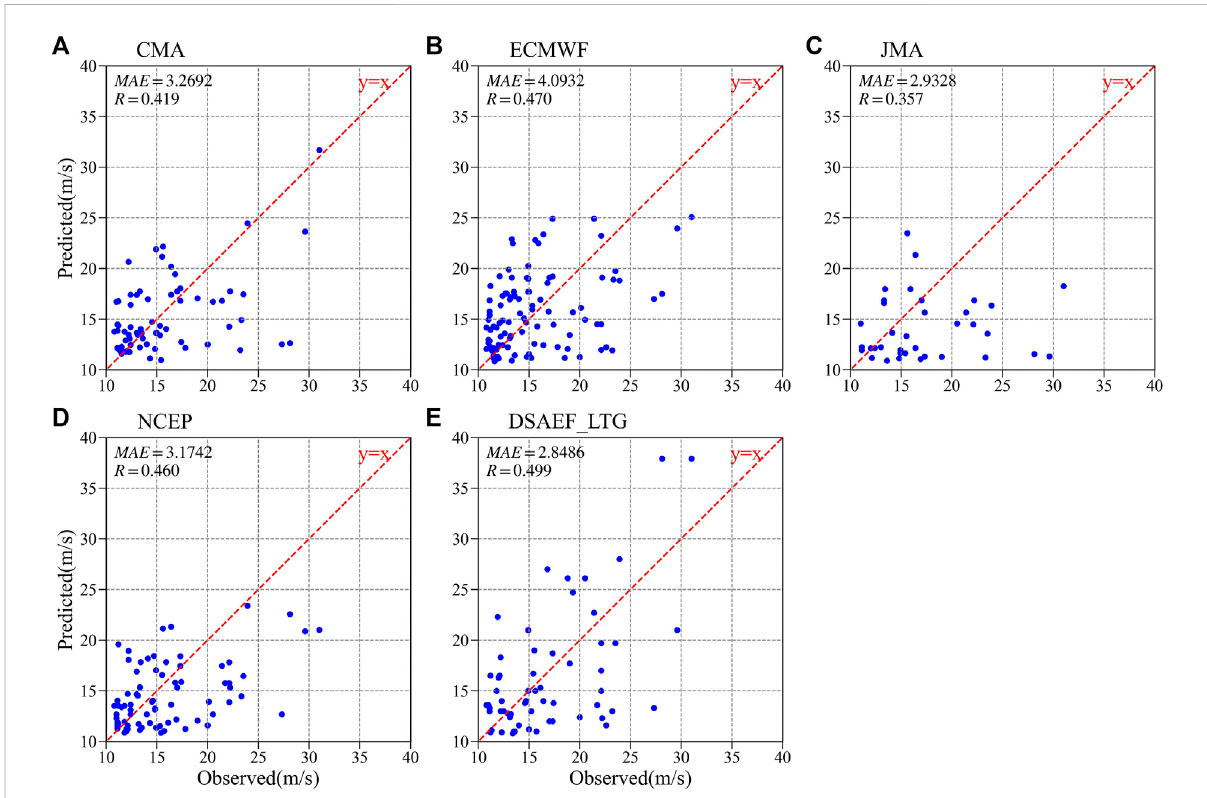
FIGURE 8 Scatter distributions ofthe predictedand observedwind speeds from fi veindependentsamples according to (A) CMA, (B) ECMWF, (C) JMA, (D) NCEP and (E) the DSAEF_LTG model. The MAE and R (passing the 0.01 signi fi cance test) of each model are also provided in the upper left. The red dotted line is a reference line where the prediction is equal to